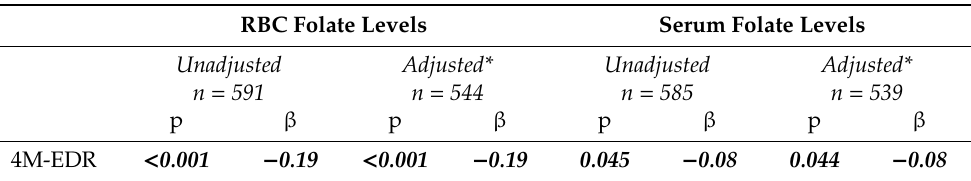
Table 4. Associations between 4 month accumulated erythemal dose rate (4M-EDR) and folate levels, with and without adjustments for folate